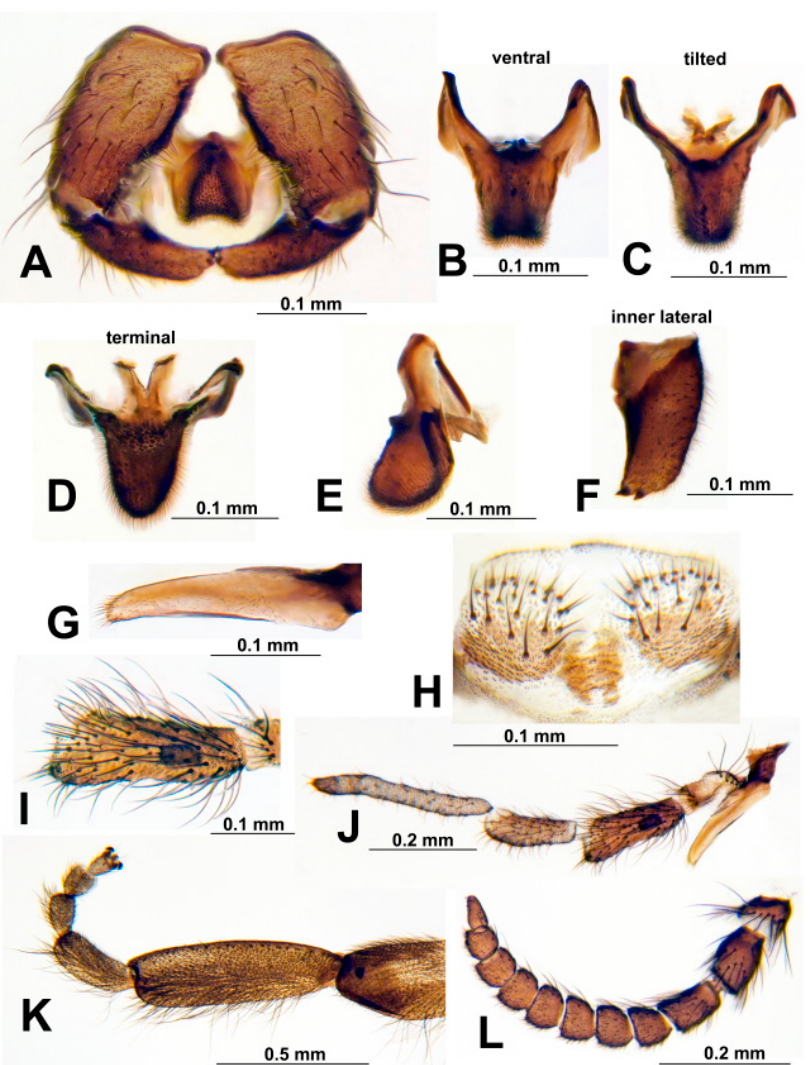
Figure 5. Male of Prosimulium supernum n. sp. ( A ) Genitalia, ventral view. ( B ) Ventral plate, ventral view (slightly tilted). ( C ) Ventral plate, ventral view (moderately tilted to show median sclerite). ( D ) Ventral plate and median sclerite, terminal view. ( E ) Ventral plate, lateral view. ( F ) Gonostylus, inner lateral view. ( G ) Lacinia. ( H ) Tergite X and cerci. ( I ) Maxillary palpomere III, showing sensory vesicle. ( J ) Maxillary palp with 5 palpomeres and lacinia. ( K ) Hind tibia (apex only), tarsus, and acropod with claws. ( L ) Antenna. Pupa . Length (excluding gills) (n = 7) 4.2–5.1 mm, mean = 4.6 mm. Cephalic plate with